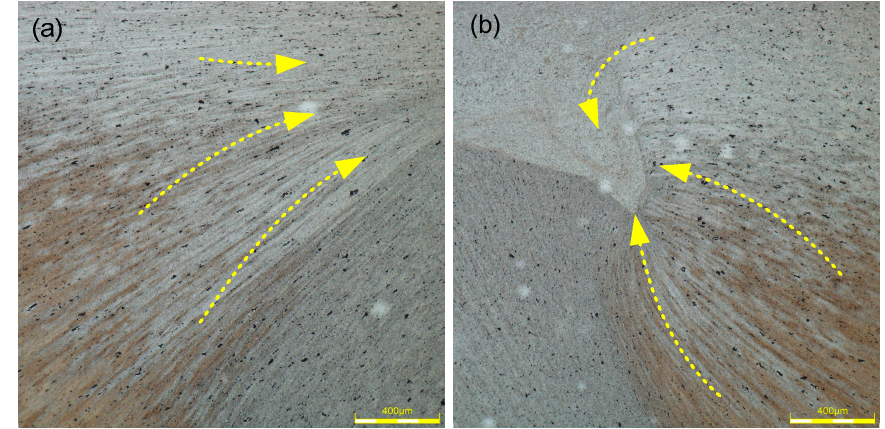
Figure 21. The material flow intersection of the welded joint. ( a ) The material intersection on the advancing side; and ( b ) the material intersection on the retreating side.